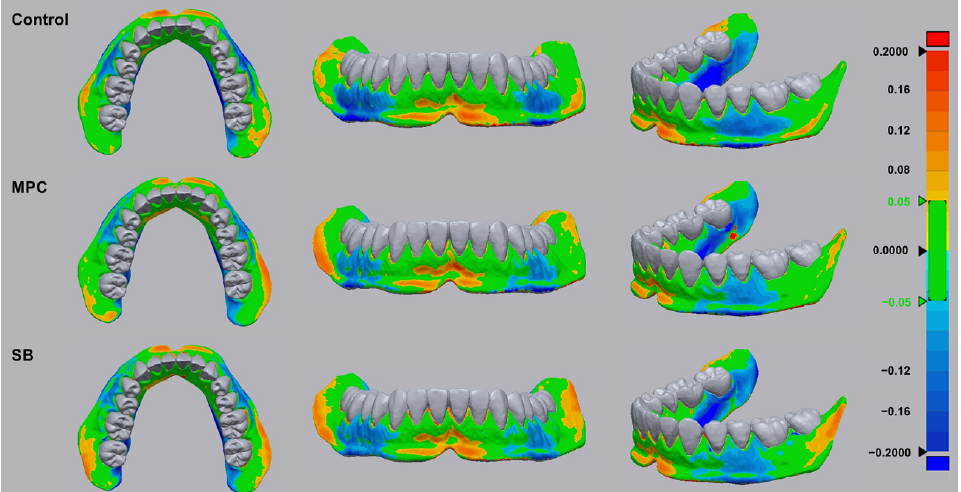
Figure 6. Superimposed optically scanned surfaces of 3D-printed dental base-like models constructed using poly(methyl methacralyate) before (Control) and after the addition of 2-methacryloyloxyethyl phosphorylcholine (MPC) or sulfobetaine methacrylate (SB). The calculated root-mean-square (RMS) values within tolerable dimensional changes with respect to those of the scanned digital file are indicated by green coloration (RMS value is set at ±0.05 µm). Red and blue indicate +0.2 µm and −0.2 µm RMS deviations from the scanned digital file, respectively.